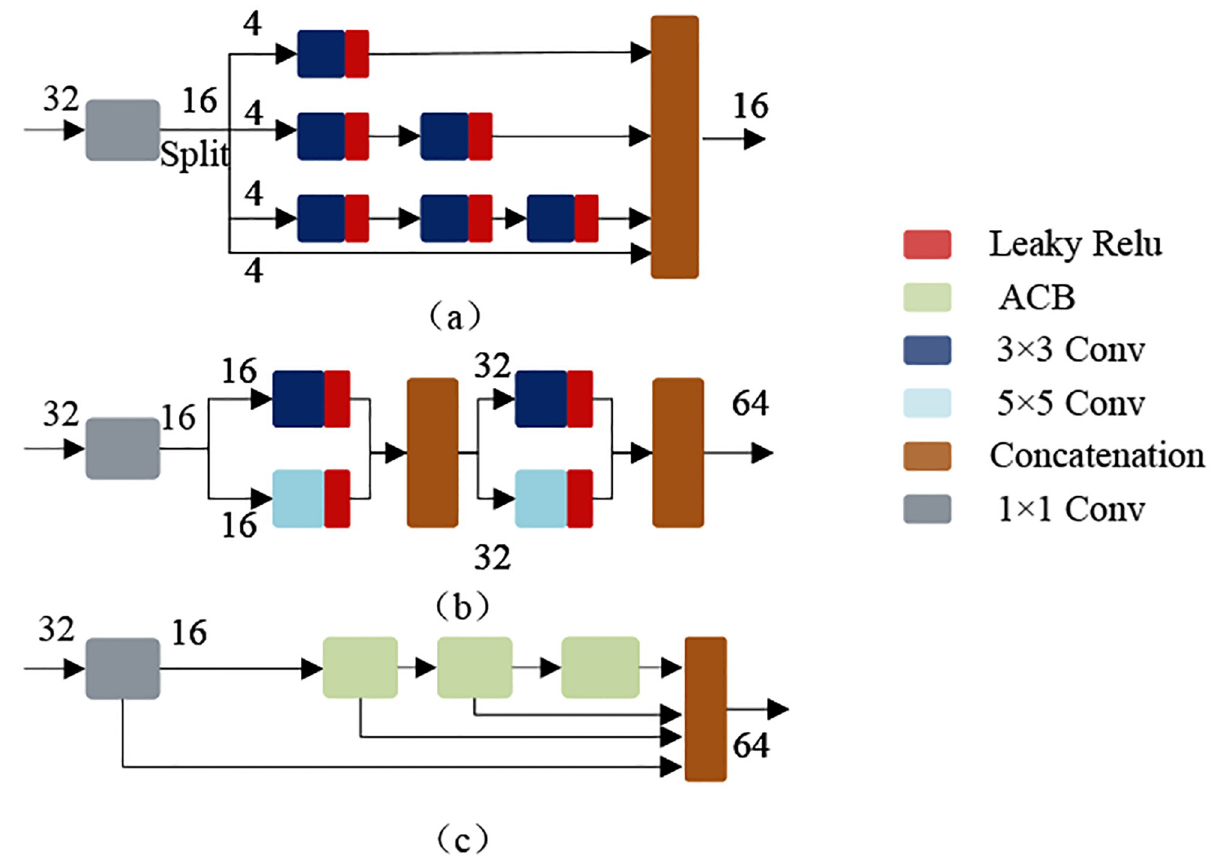
Fig 9. Feature extraction structure of different methods. (a) Split+Conv3. (b) Conv3+Conv5. (c) IAB.